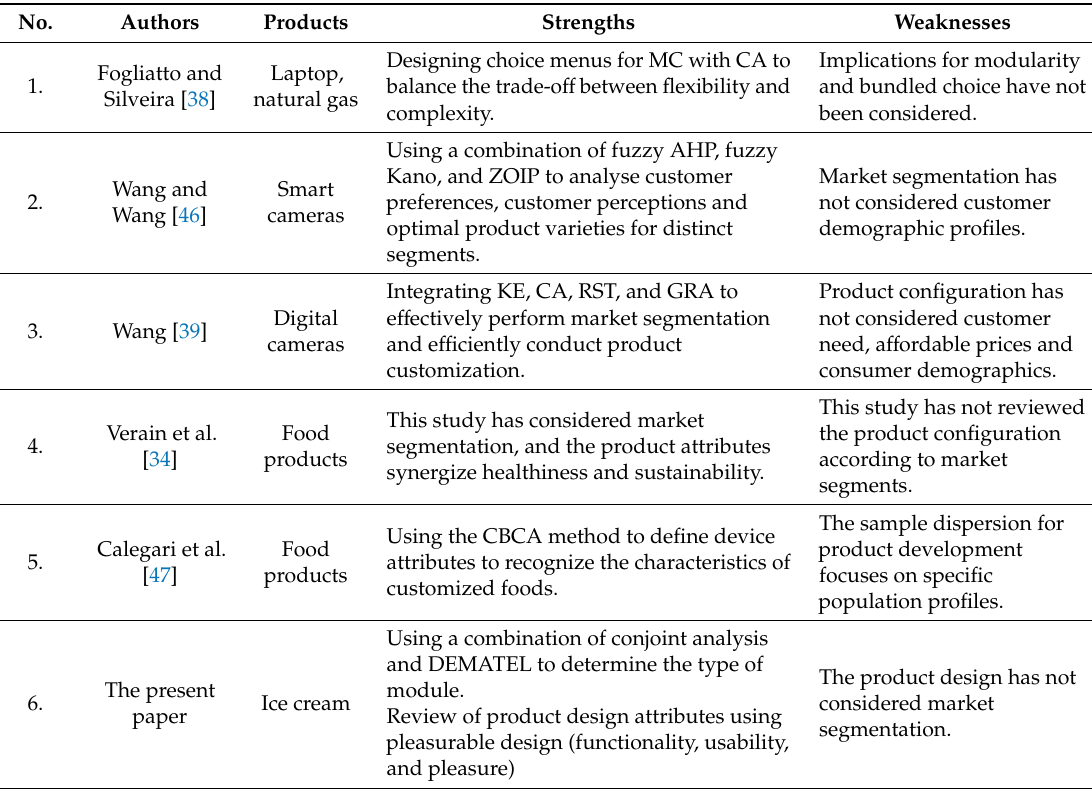
Table 2. Comparison of the present study with other published